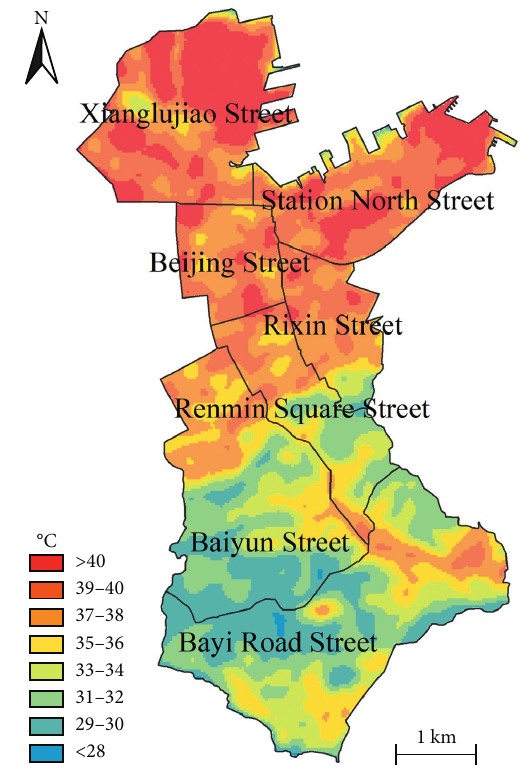
Figure 2: Surface temperature